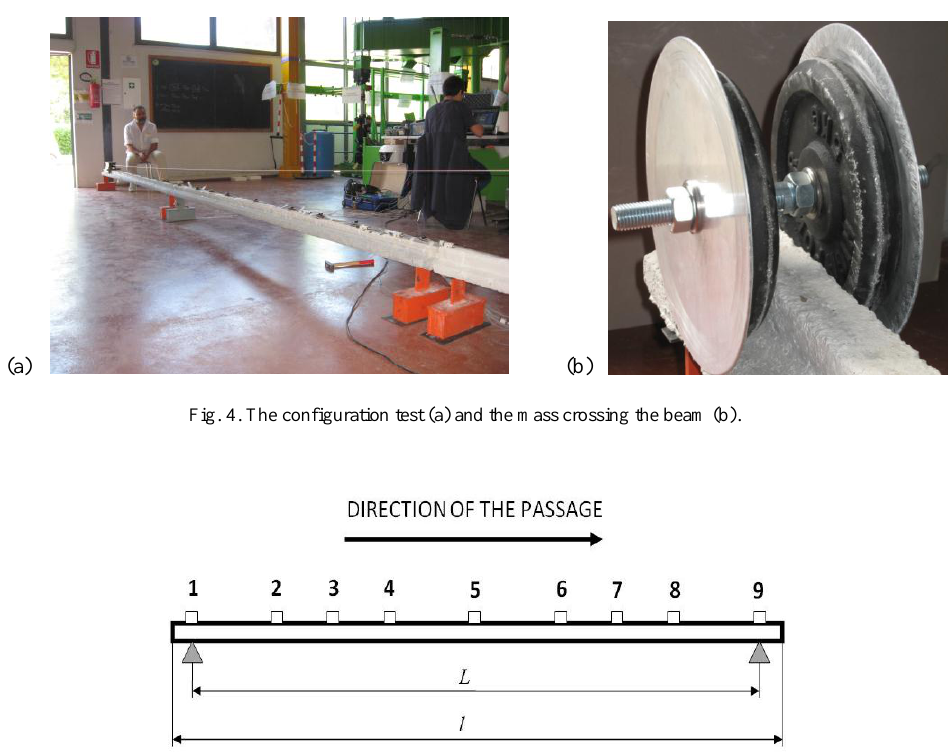
Fig. 5. The scheme of the beams analyzed in Pescara